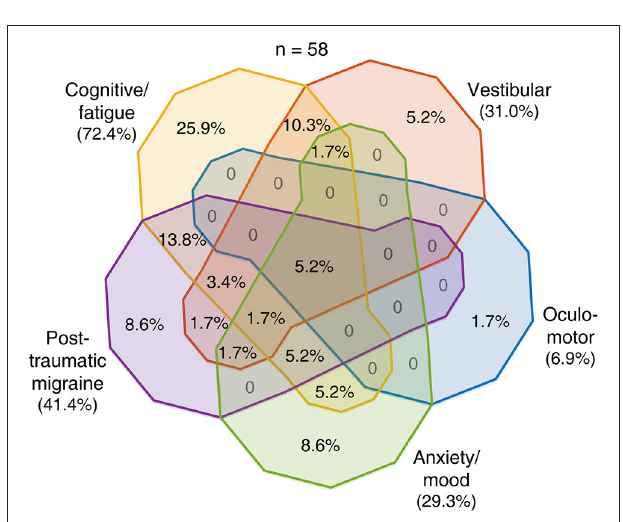
FIGURE 3 | Overlaps in post-concussion profile characteristics identified with at-least-moderate symptoms. Fifty-seven of 89 concussed subjects reported having an at-least moderate post-concussion symptom. The distribution of these 57 subjects among the various combinations of presences and absences of endorsement of the five symptom classes is shown as percentages in the Venn